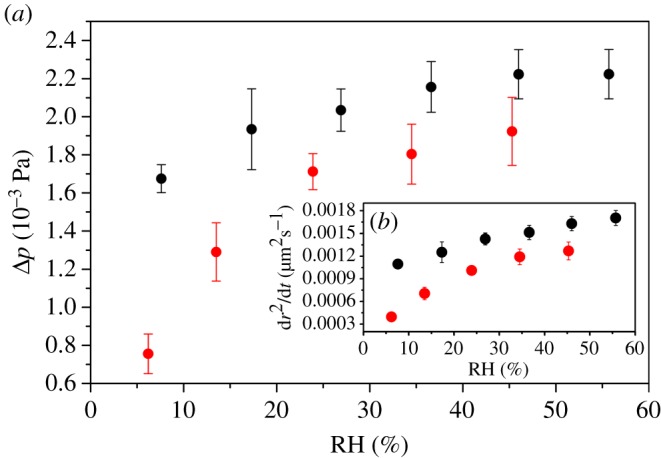
The values of Δp and dr2/dt for the OIRs of 1 : 1 (red) and 1 : 3 (black) at different RHs after NaNO3 crystallized in the deposited droplets.